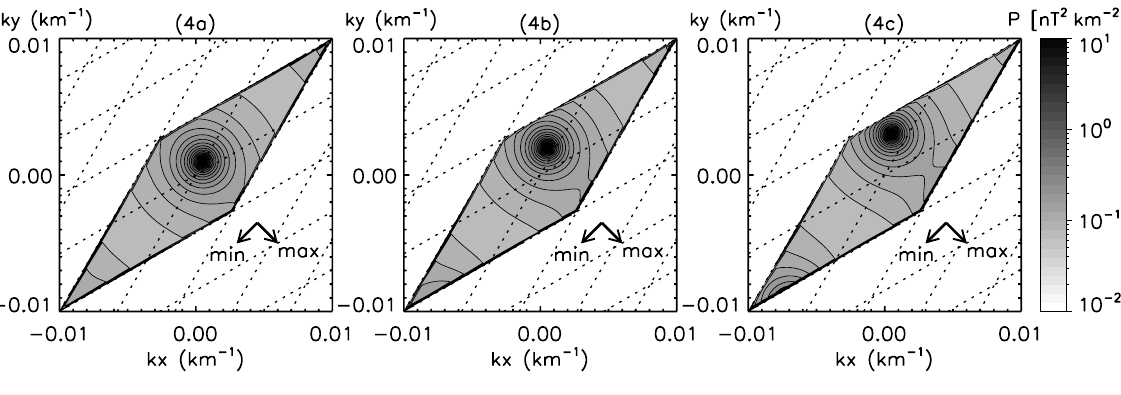
Fig. 9. Aliased spectra for different peak positions in a diamond-shaped Brillouin zone. The peak is shifted to the top side of the Brillouin zone. Peak close to the origin in the cell (left), between the origin and the border of the cell (middle), and near the border (right).